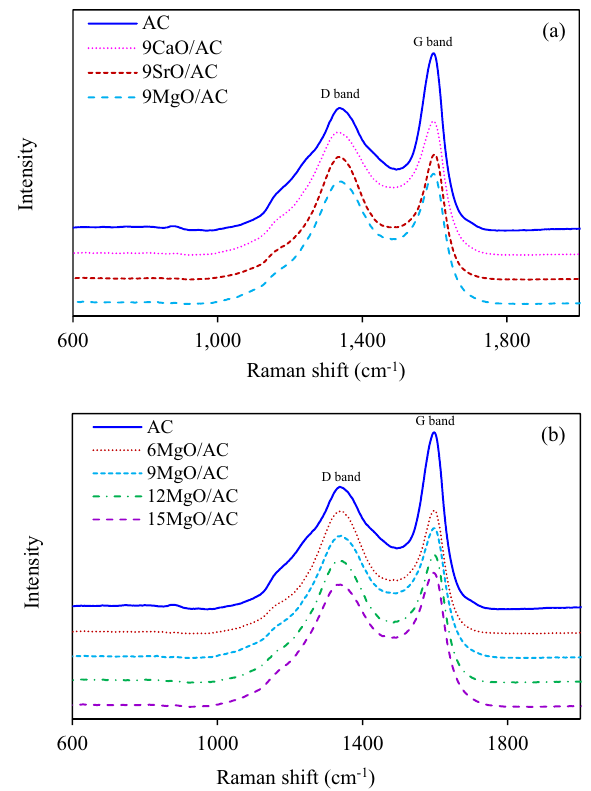
Figure 5. Raman spectra of ( a ) 9MO/AC and ( b ) x MgO/AC samples.